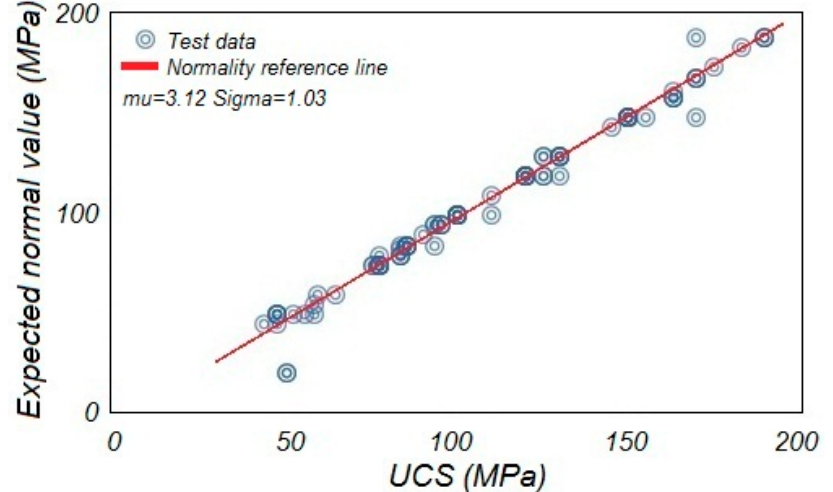
Figure 3. The Q–Q chart for normality tests of UCS results.